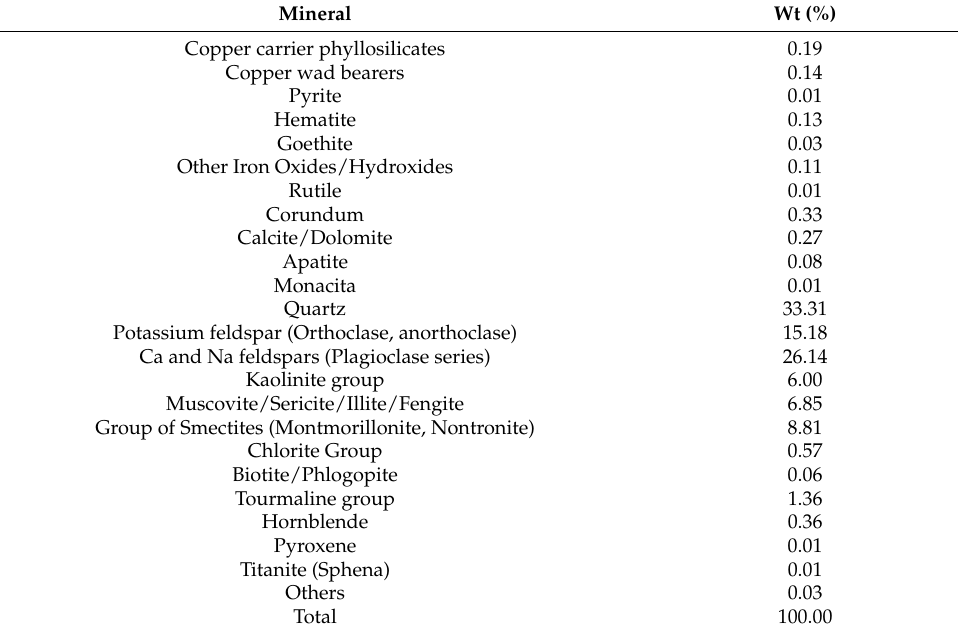
Table 1. Mineralogical composition of the